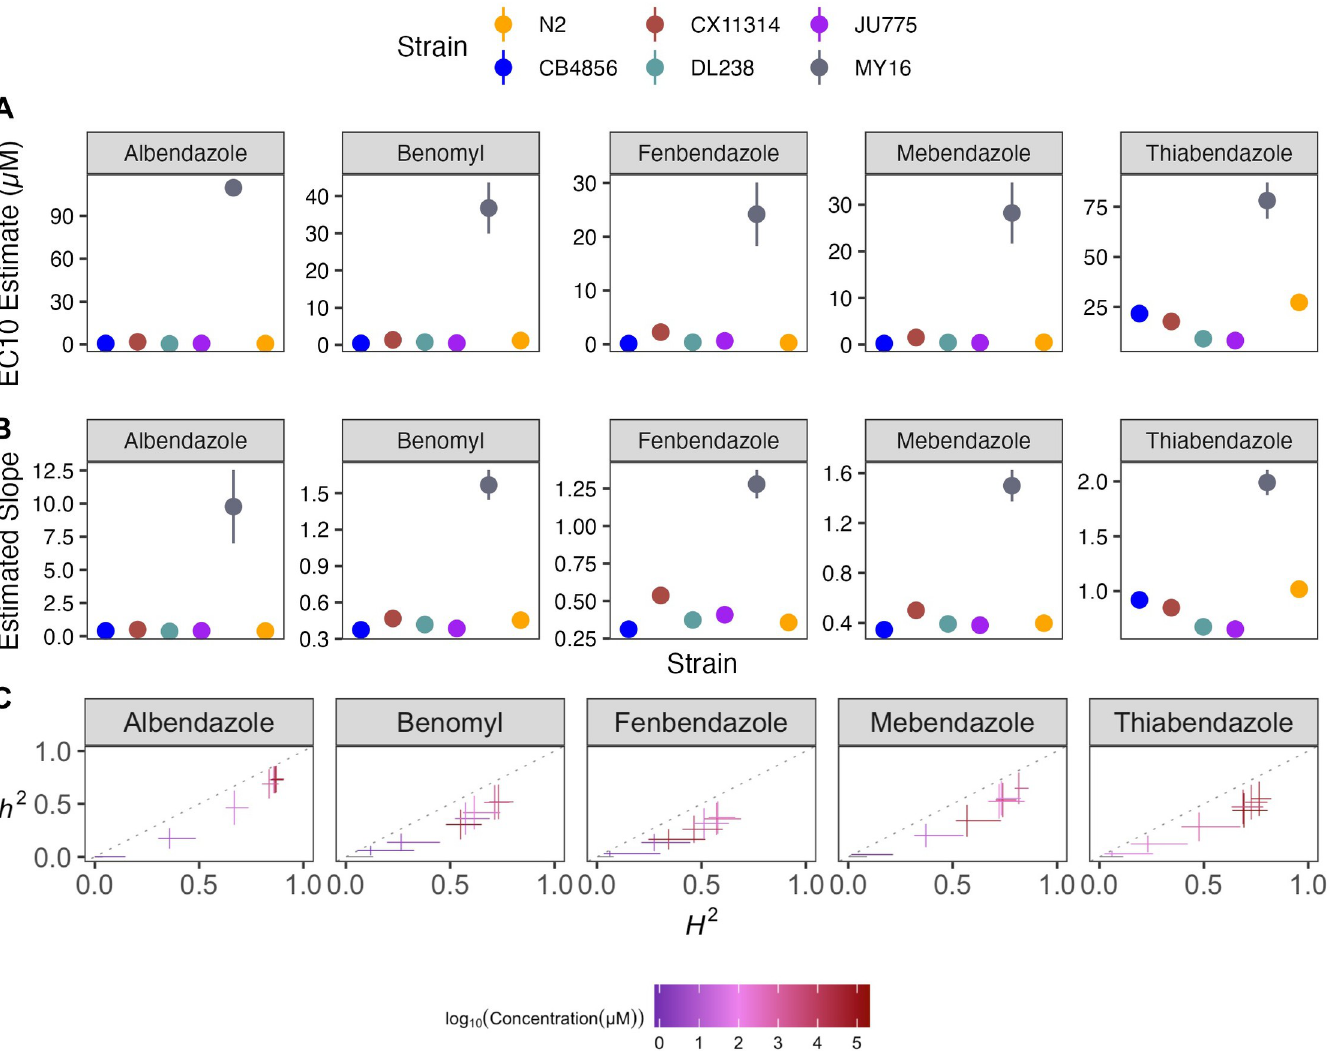
Fig 3. Variation in benzimidazole (BZ) EC 10 dose-response and slope estimates can be explained by genetic variation across strains. (A) Strain-specific EC 10 estimates ( e ) for each benzimidazole are displayed for each strain. Standard errors for each strain- and anthelmintic-specific EC 10 estimates are shown. (B) Strain-specific slope estimates ( b ) for each benzimidazole are displayed for each strain. Standard errors for each strain- and anthelmintic-specific slope estimate are indicated by the line extending vertically from each point. (C) The broad-sense (x-axis) and narrow-sense heritability (y-axis) of normalized animal length measurements were calculated for each concentration of each benzimidazole ( Methods ; Broad-sense and narrow-sense heritability calculations ). The color of each cross corresponds to the log-transformed dose for which those calculations were performed. The horizontal line of the cross corresponds to the confidence interval of the broad-sense heritability estimate obtained by bootstrapping, and the vertical line of the cross corresponds to the standard error of the narrow-sense heritability estimate.